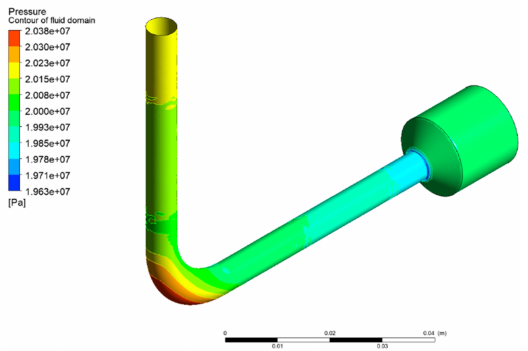
Figure 9. Pressure distribution on the interface of the optimized fluid domain (Re = 5908 and Ma = 0.022 at the bent 45 ◦ cross